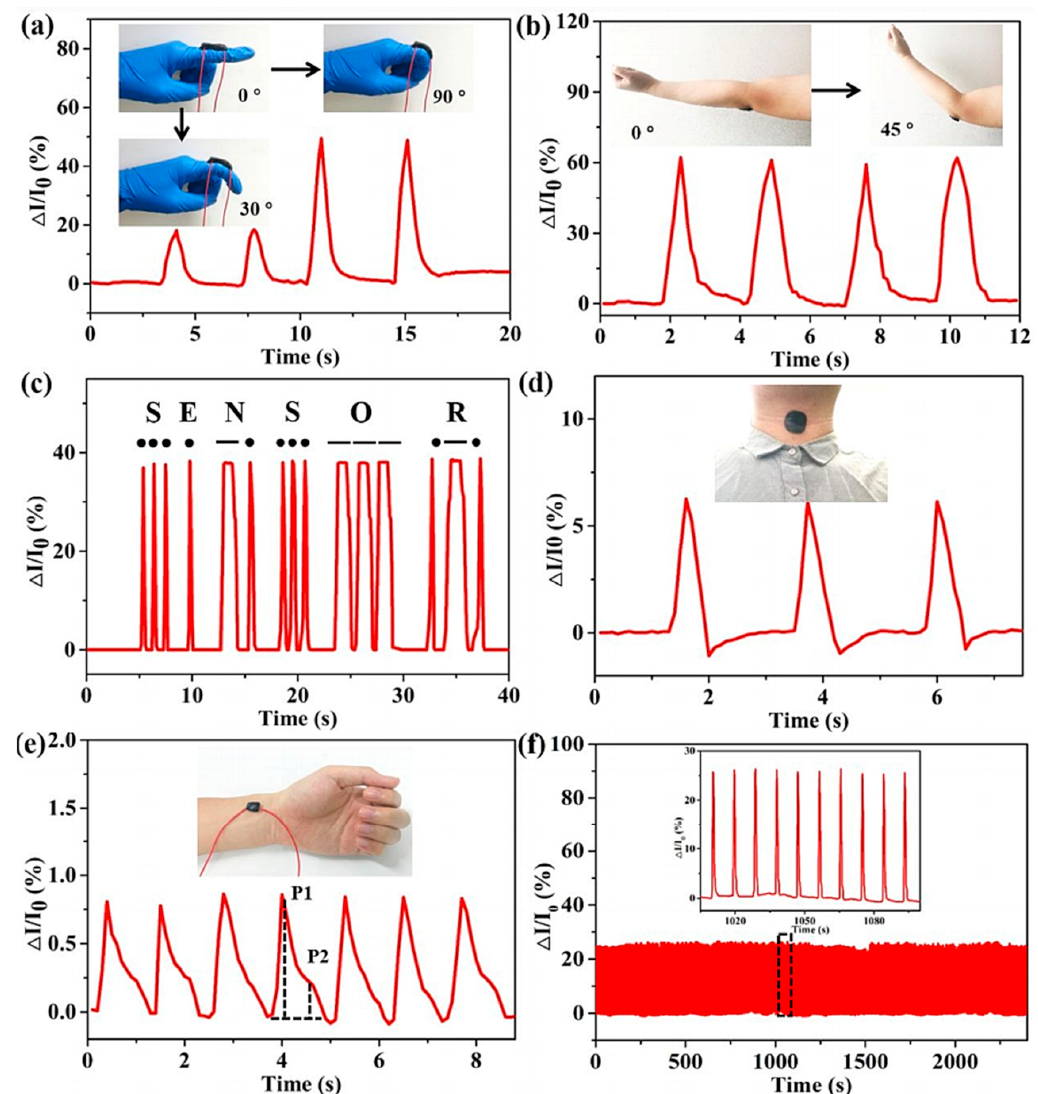
Figure 6. Detection of human motions by wearable organohydrogel-based sensors: ( a ) Sensor under finger bending with different angles; ( b ) Sensor under elbow bending with different angles; ( c ) Sensor by pressing; ( d ) Sensor under swallowing; ( e ) Sensor detecting pulse; ( f ) Durability measurement. Reprinted with permission from [39].